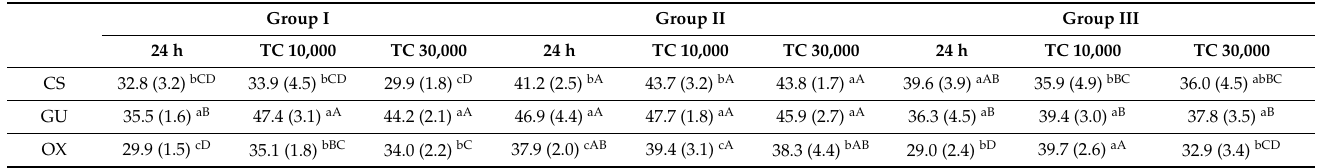
Table 3. Influence of application method on enamel bond strength (SE mode).